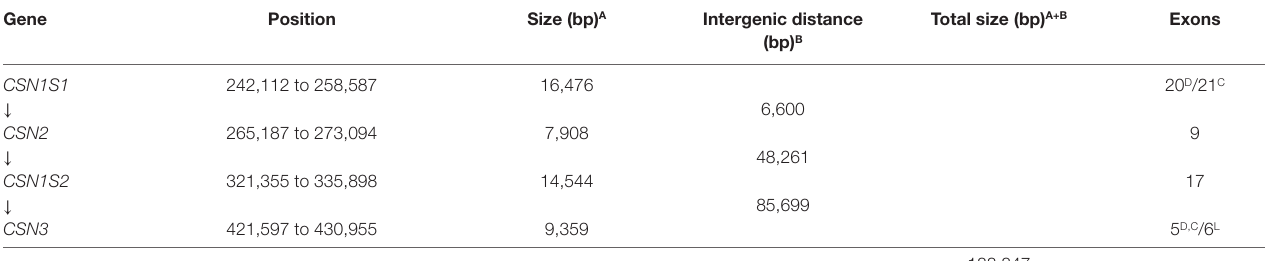
TABLE 2 | Positions, sizes, and exon numbers of the casein genes and related intergenic distances occurring in the cluster. The contig 039344 available in EMBL with the acc. no. AGVR01039100.1 and isolated from the whole genome sequence of the feral camel (Bactrian Camels Genome Sequencing and Analysis Consortium) was used as reference. D, Dromedary; C, other camelids; L, Llama (Pauciullo and Erhardt, 2015).